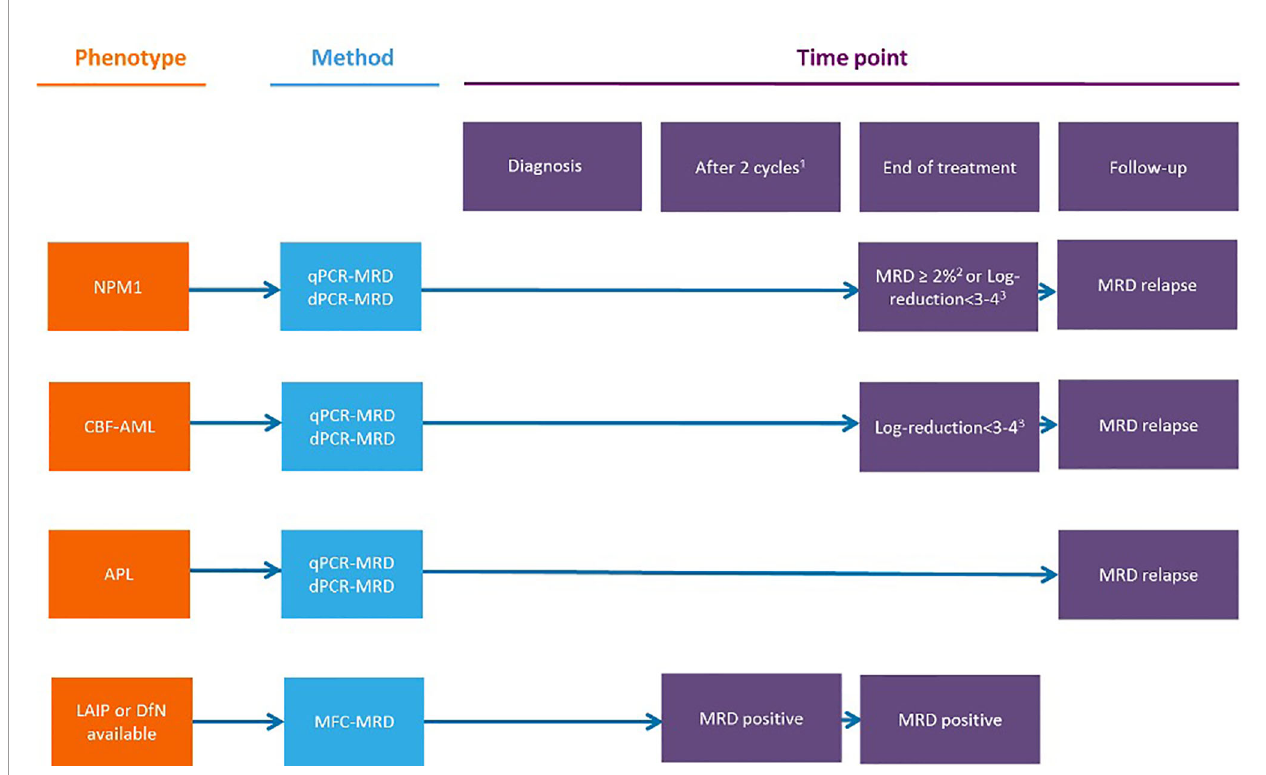
FIGURE 3 | Measurable residual disease response and prognosis in treatment-na ı ve acute myeloid leukemia with venetoclax and azacytidine. (A) DoR among patients with composite complete remission. (B) Forest plot for DoR in subgroups (20). Figure from Pratz KW, et al. JCO 2021 (20). CR, complete remissions; CRi, complete remission with incomplete hematologic recovery; DoR duration of remission; MRD, measurable residual disease; NR, not